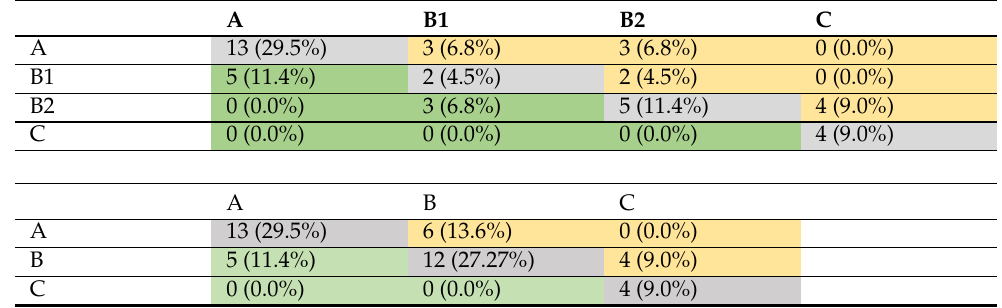
Table A1. Table summarizing sunitinib treatment responses. Yellow boxes correspond to tumor progression under treatment, n = 10 cases (22.7%), grey boxes correspond to stabilization n = 29